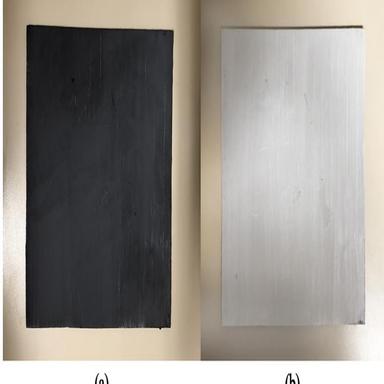
Thermochromic roof coating in the (a) colored and in the (b) non-colored phase.